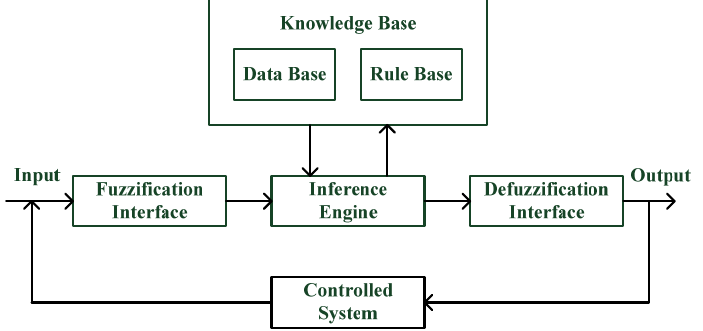
Figure 1. Fuzzy logic control architecture.